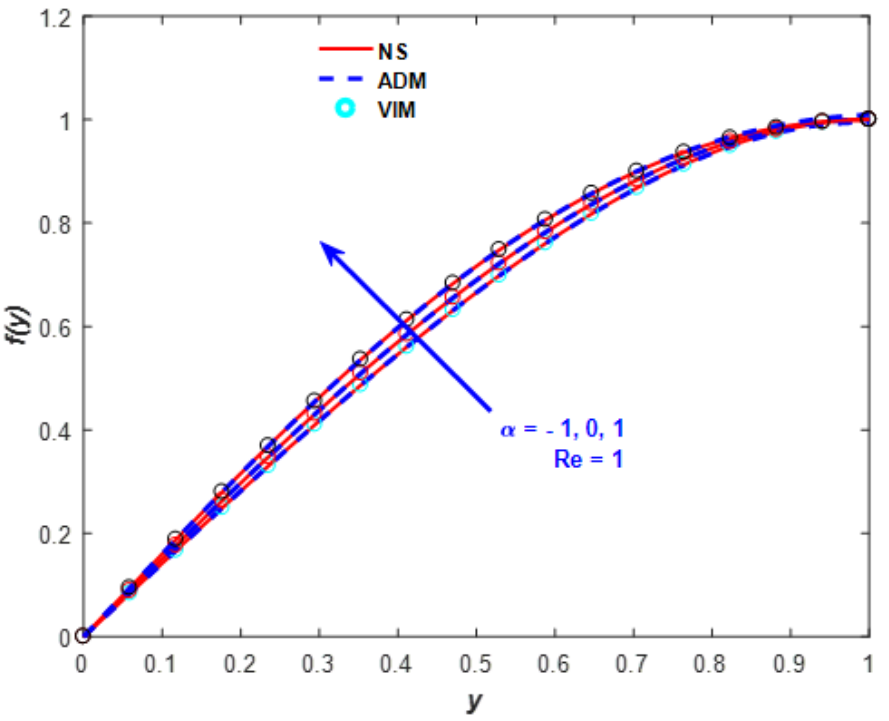
Figure 9. Behavior of f ( y ) with variation of α simulated by numerical simulation, ADM and VIM.